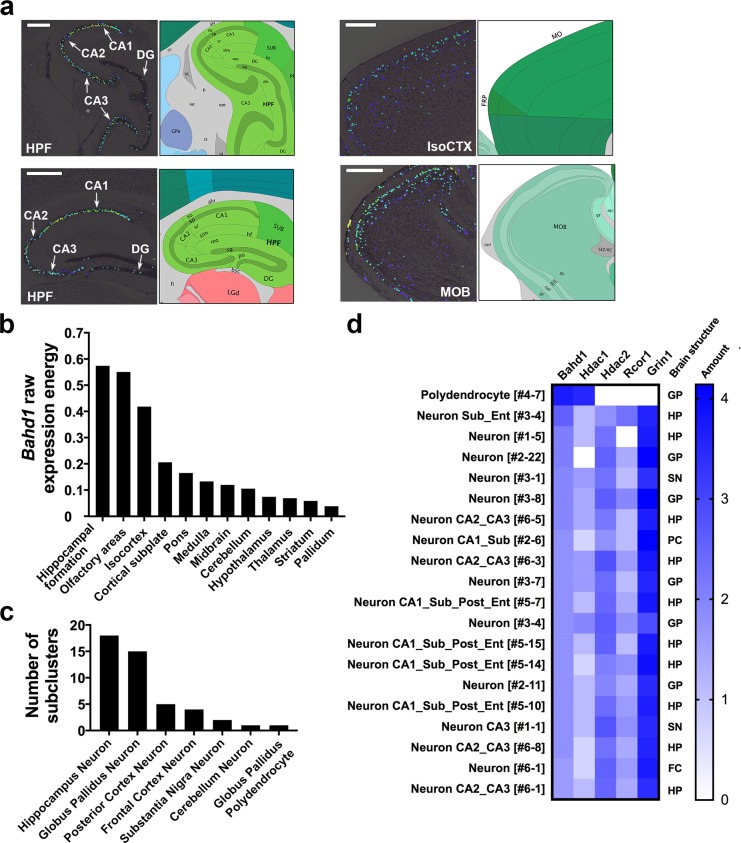
Expression of Bahd1 in the mouse brain.(a) Examples of sagittal sections of brain regions with the highest Bahd1 expression in the Allen Brain Atlas [22] (version 2019) showing the expression mask overlaid on the ISH (Left) and the corresponding atlas section (Right). Color code: Bahd1 expression from the lowest (dark blue) to the highest level (yellow). Hippocampal Formation (HPF); Cornu Ammonis areas CA1, CA2, CA3; Dentate Gyrus, DG); Isocortex (IsoCTX); Olfactory Bulb (MOB). (b) Expression of Bahd1 across the 12 major brain structures (from highest to lowest level). Reported values represent the average expression per region normalized to the average expression across the whole brain. (c) Number of brain cell subclusters with the highest Bahd1 expression in the DropViz single‐cell gene expression database [24]. (d) Heat map showing the highest expression values for Bahd1 in the cell subclusters in the DropViz database in comparison with that of Hdac1, Hdac2 and Rcor1. Grin1 was used as a control for a brain-specific gene. GP: Globus Pallidus; HP: Hippocampus; SN: Substantia Nigra; PC: Posterior Cortex; FC: Frontal Cortex.